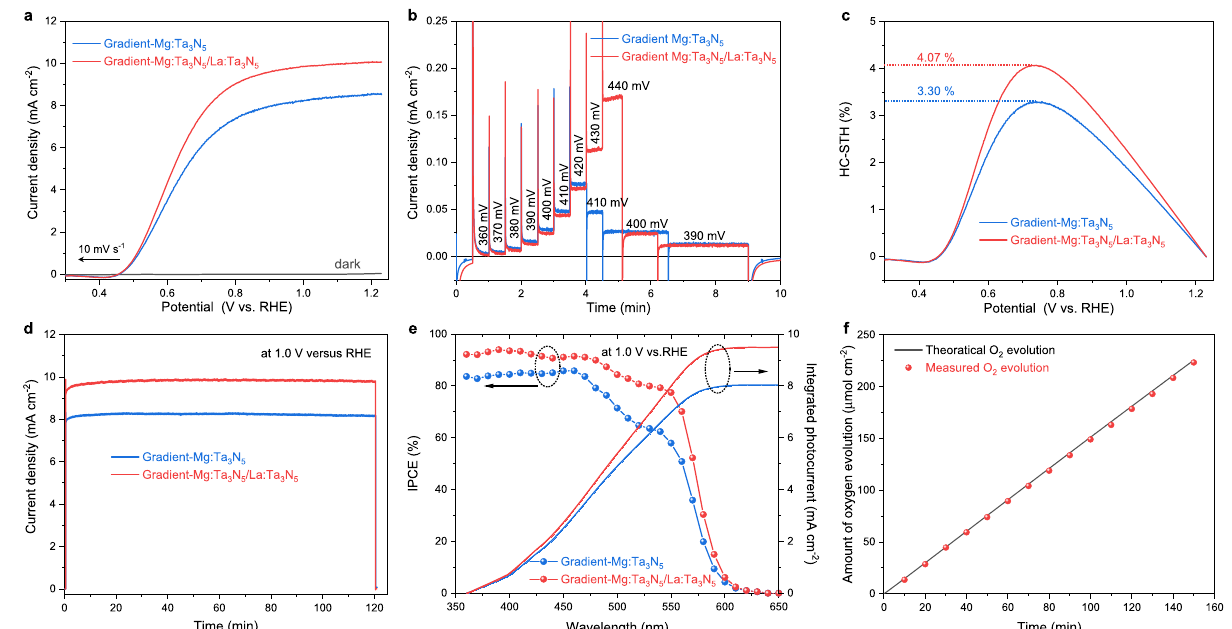
Fig. 5 | Solar-driven PEC water oxidation properties of gradient-Mg:Ta 3 N 5 / La:Ta 3 N 5 photoanode.a J – V curvesforgradient-Mg:Ta 3 N 5 andgradient-Mg:Ta 3 N 5 / La:Ta 3 N 5 photoanodes with NiCoFe-B i co-catalyst in 1M KOH under AM 1.5G simulated sunlight. b Steady-state photocurrent of gradient-Mg:Ta 3 N 5 /La:Ta 3 N 5 photoanodeunderlowappliedpotentials. c HC-STHofthephotoanodescalculated from J – V curves in ( a ). d Steady-state photocurrent for gradient-Mg:Ta 3 N 5 and gradient-Mg:Ta 3 N 5 /La:Ta 3 N 5 photoanodeswithNiCoFe-B i co-catalystat1.0Vversus